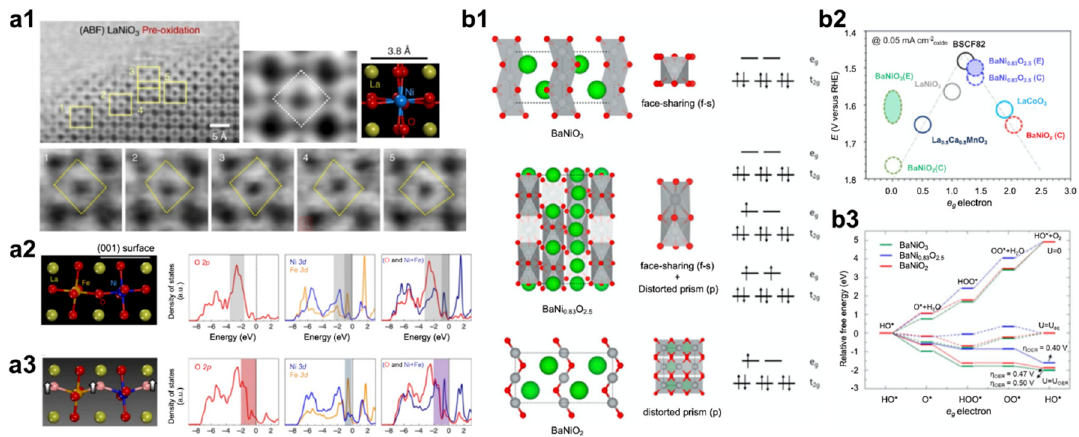
Figure 6. ( a ) Perturbation of oxygen octahedral in LaNiO 3 activates the water oxidation reaction: ( a1 ) STEM image of the distorted oxygen octahedron; and a (density of states) DOS comparison between Fe-doped (001) LaNiO 3 ( a2 ) without and ( a3 ) with distorted octahedral oxygen atoms; reproduced with permission [98] Copyright (2019), Springer Nature. ( b ) BaNi 0.83 O 2.5 as a superior OER electrocatalyst: ( b1 ) structures of BaNiO 3 , BaNi 0.83 O 2.5 , and BaNiO 2 , ( b2 ) OER activity as a function of the e g orbital occupancy, and ( b3 ) DFT-calculated free energy diagrams; reproduced with permission [99] Copyright (2016), American Chemical Society.